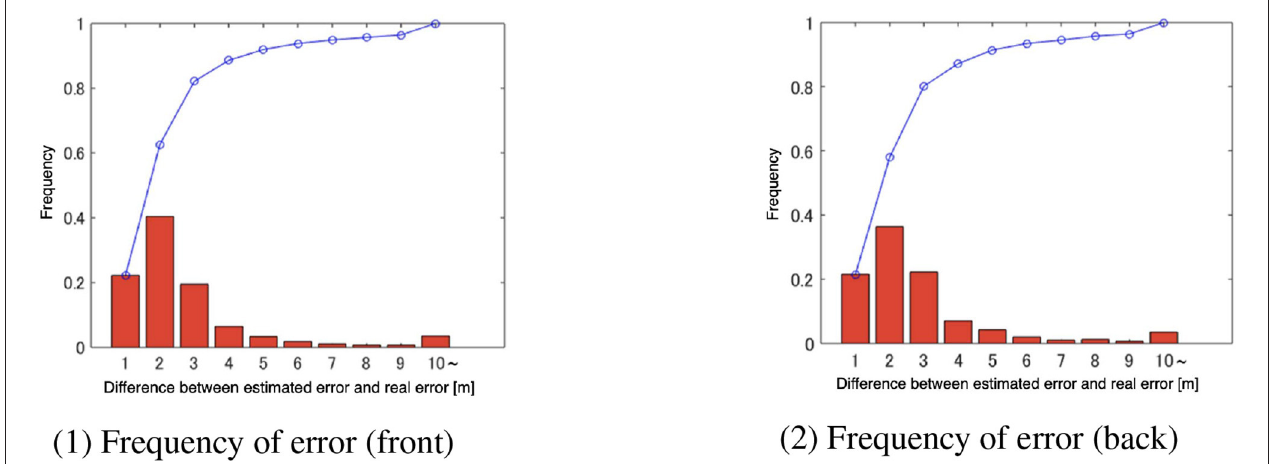
FIGURE 10 | Frequency of